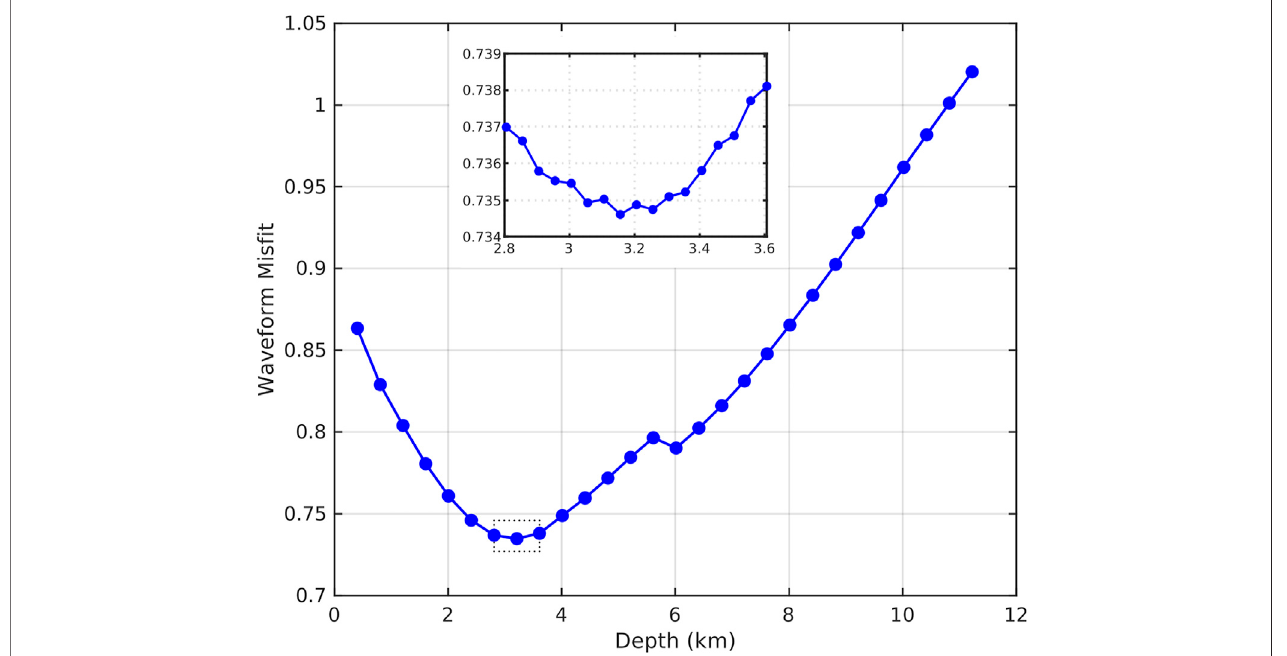
FIGURE 8 | The curve of waveform mis fi ts vs. trial event depths with the horizontal location fi xed. The middle solid rectangle is a partial enlarged drawing for local smaller grid-searching size (50 m) from 2.8 km and 3.6 km depth.